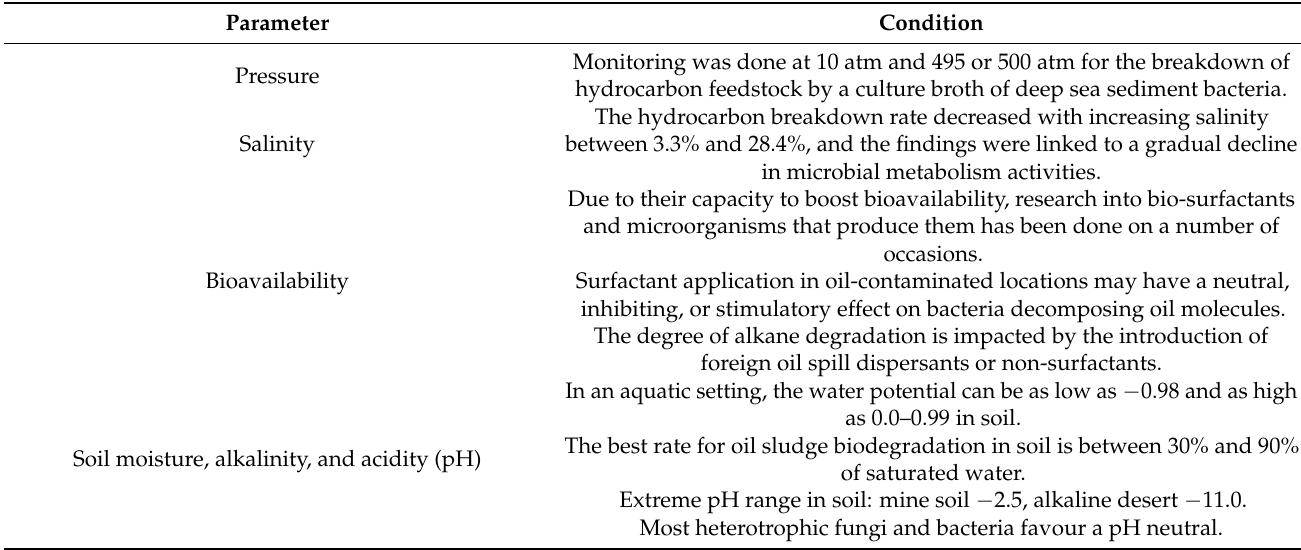
Table 3. Influential factors of microbial ecology adapted and modified from Okoh [50] and Singh & Chandra